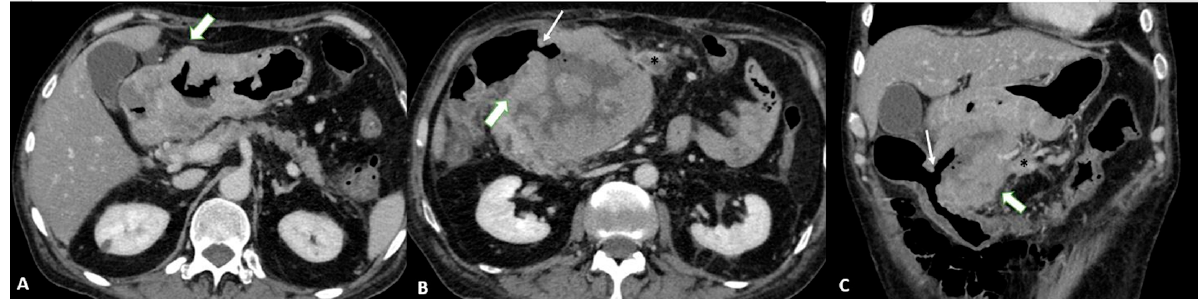
Figure 5. T4b gastric cancer in a 74-year-old female patient. ( A , B ). Axial 2D images in the portal venous phase and ( C ) Coronal multiplanar reconstruction showing (thick arrows) a bulky tumor of the middle-low body of the stomach and of the gastric antrum with necrotic-colliquative components inside, ulcerative alterations and some solid deposits (black asterisks) in the perivisceral fat tissue. The tumor fistulizes and infiltrates the transverse colon (thin arrows).